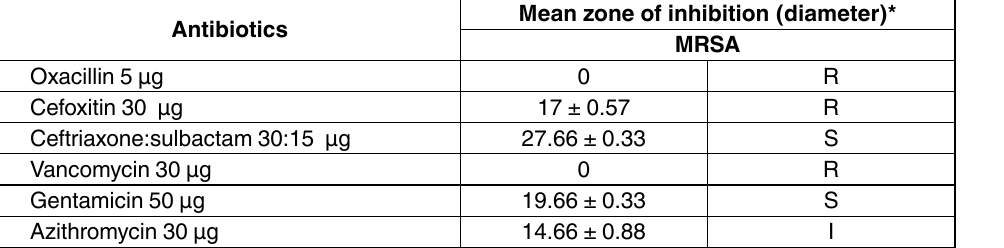
table 1. In vitro antibacterial activity of antibiotic discs against MRSA using Kirby- Bauer agar disc diffusion method, mm